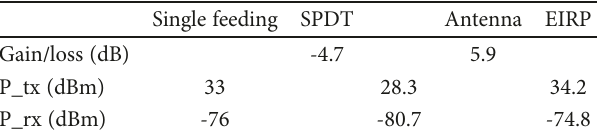
Table 2: Link budget analysis for the IEEE 802.11b speci fi cation. Single feeding